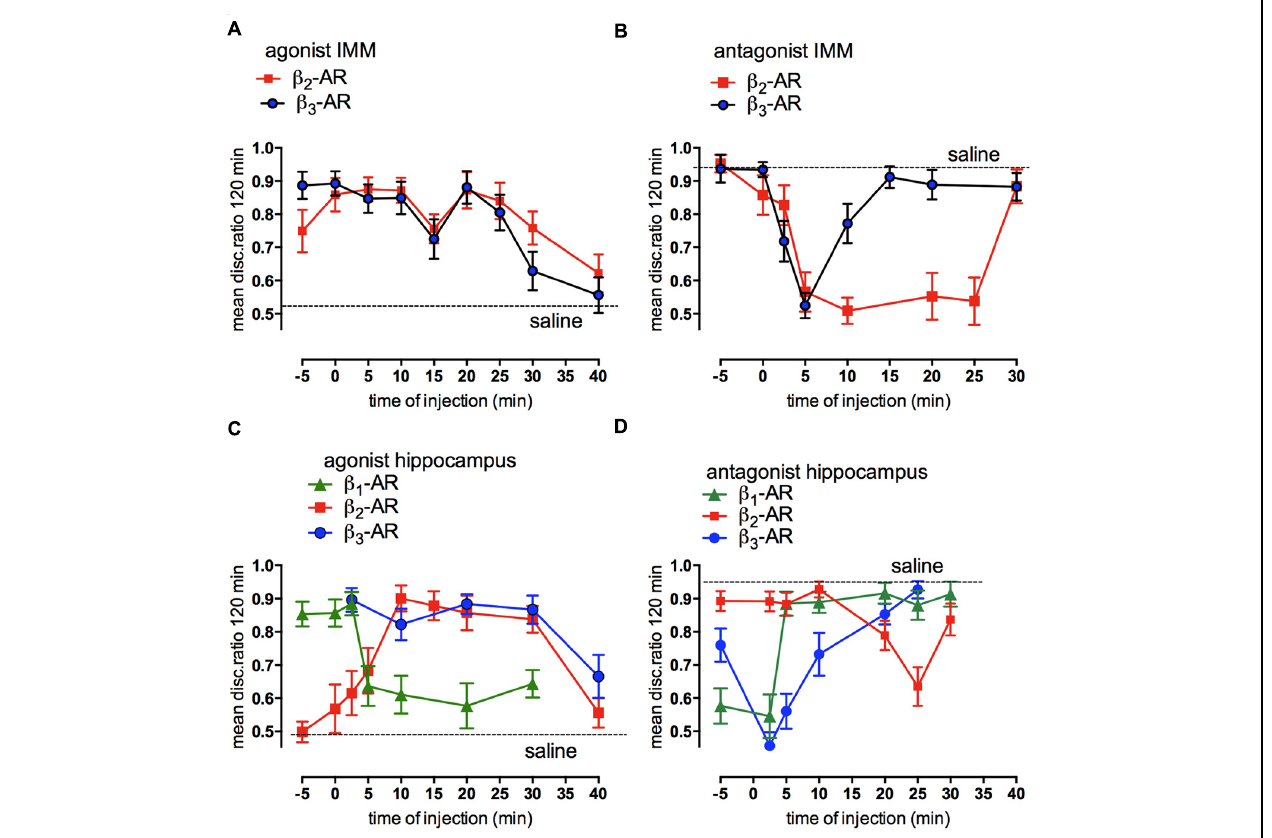
FIGURE 4 | Involvement of β -adrenoceptors in weakly- and strongly reinforced memory in both avian cortex (IMM) and hippocampus. Injections of selective β -AR agonists at different times after weakly reinforced training in IMM (A) or hippocampus (C) and of selective antagonists for β -ARs in IMM (B) or hippocampus (D) after strongly reinforced learning. Memory tested 120 min after training. (From Gibbs, 2008).